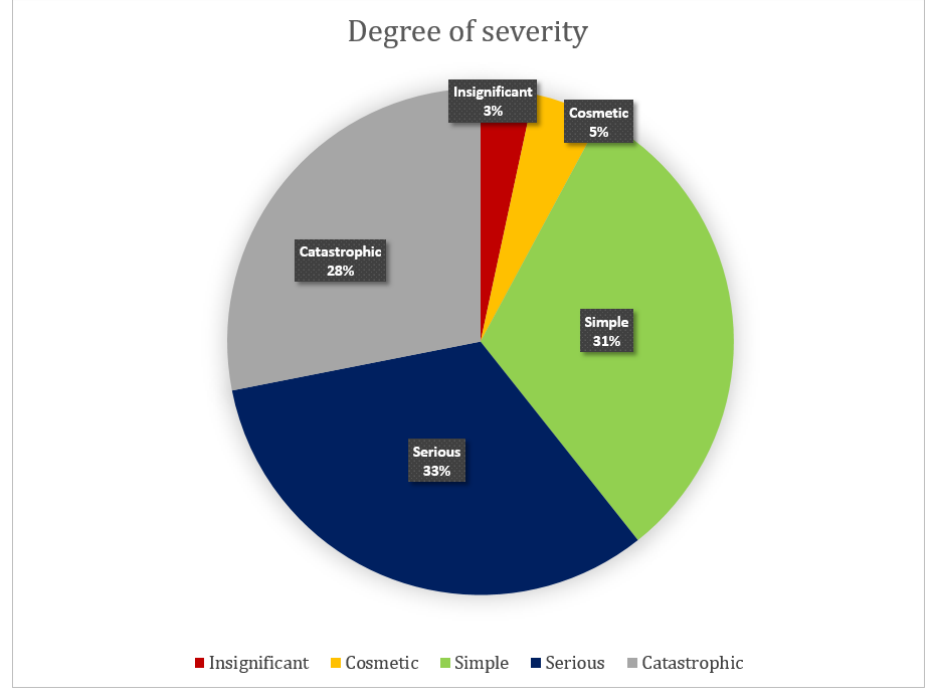
Figure 4. Degree of severity attributed in the heuristic evaluation of the prediction servers of 3D protein